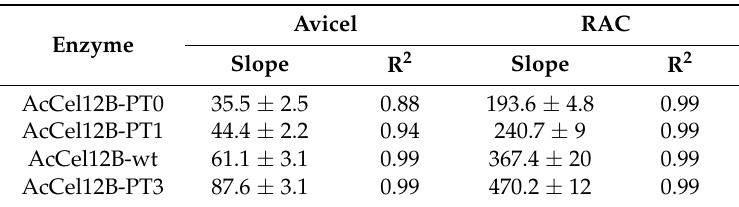
Table 4. Linear fitting curve parameters of desorption of AcCel12B and its mutants at low SDS concentrations (0.04–0.065% g/mL).